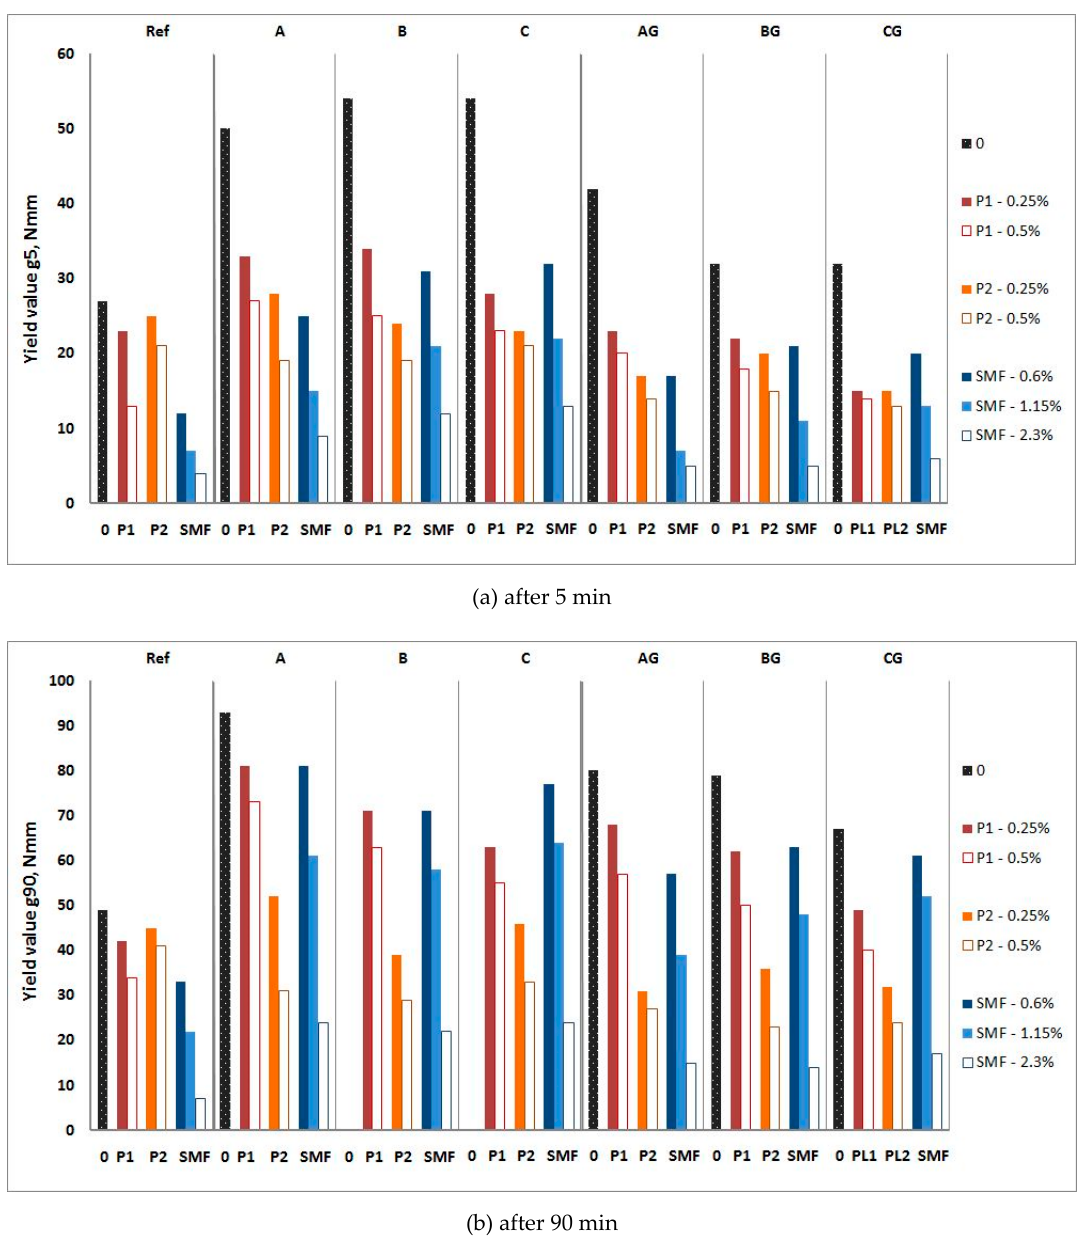
Figure 10. Influence of P1 and P2 and SMF on yield value g of mortars with raw and ground CFA. ( a ) after 5 min; ( b ) after 90 min.